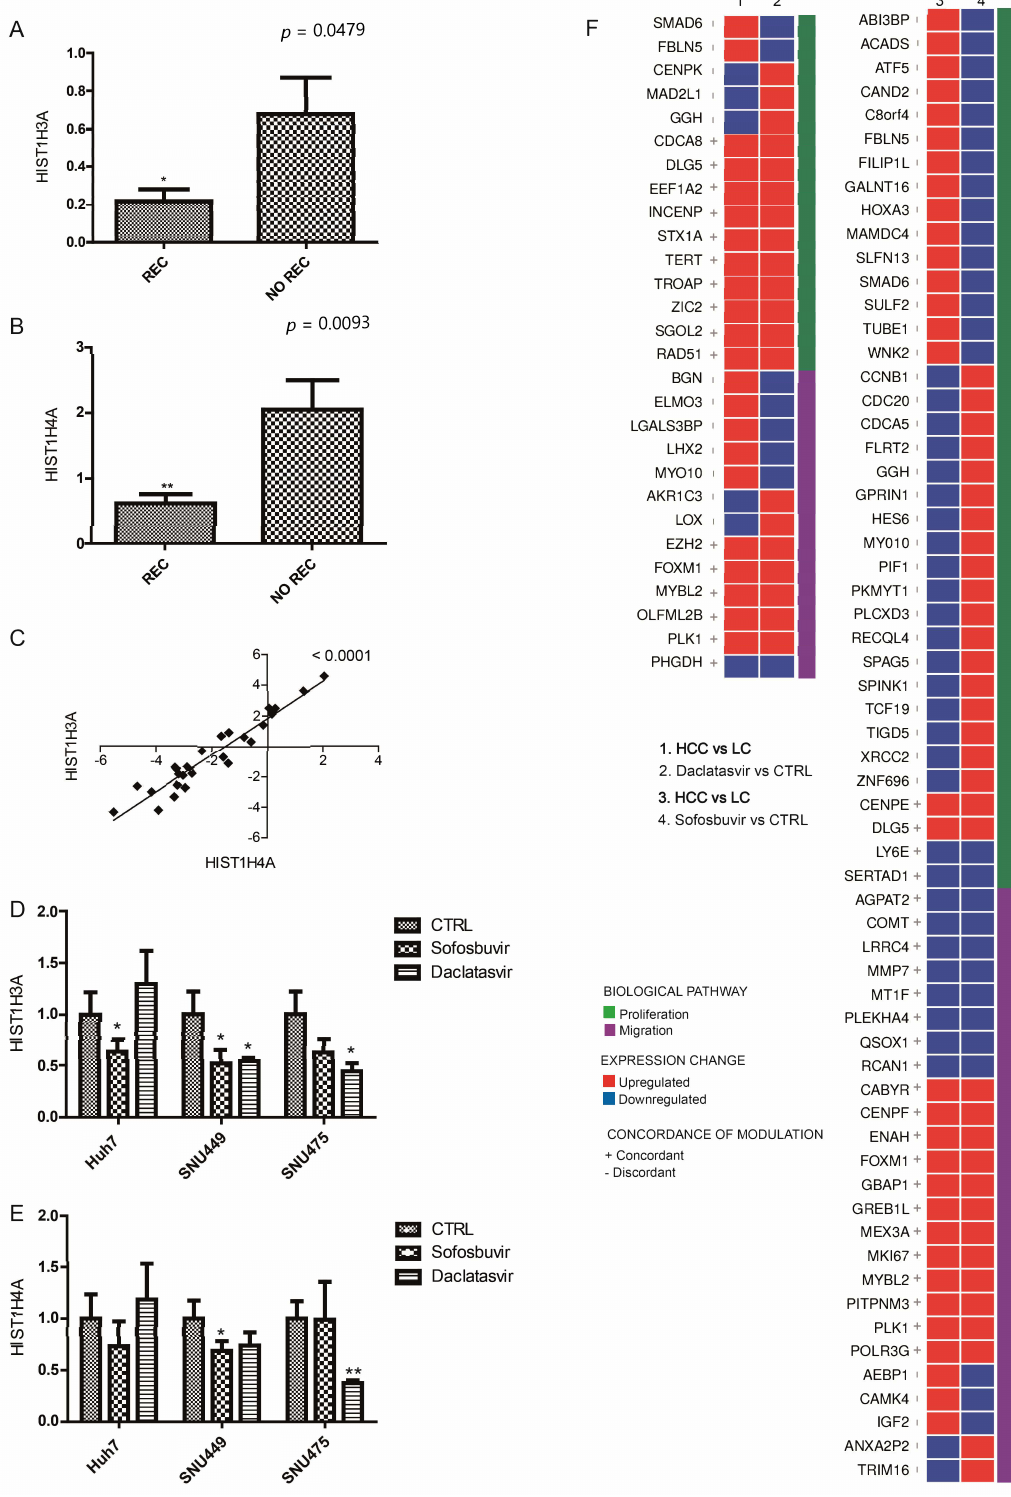
Figure 4. Histone gene expression in DAA-treated cells and primary HCCs. ( A , B ) Column graphs of Histone cluster 1 H3 family member A (HIST1H3A) and Histone cluster 1 H4 family member A (HIST1H4A) gene expression in HCCs with (REC) or without (NO REC) tumor recurrence (‘control cohort’). On the top of each graph is reported the p -value relative to Student’s t -test. Y-axes report 2 ( − ∆∆ Ct) values. Mean ± SEM values are reported. ( C ) Correlation graph between